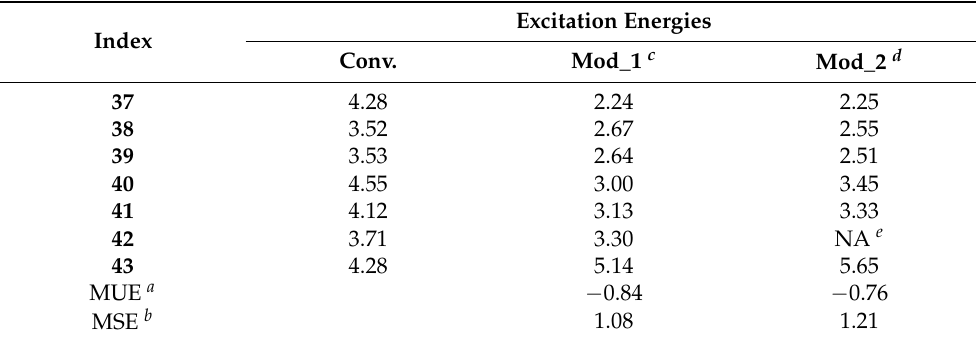
Table 8. Comparison of the excitation energies (in eV), as predicted with the multivariant linear regression equations for all the systems in Scheme 3, with conventional data as a